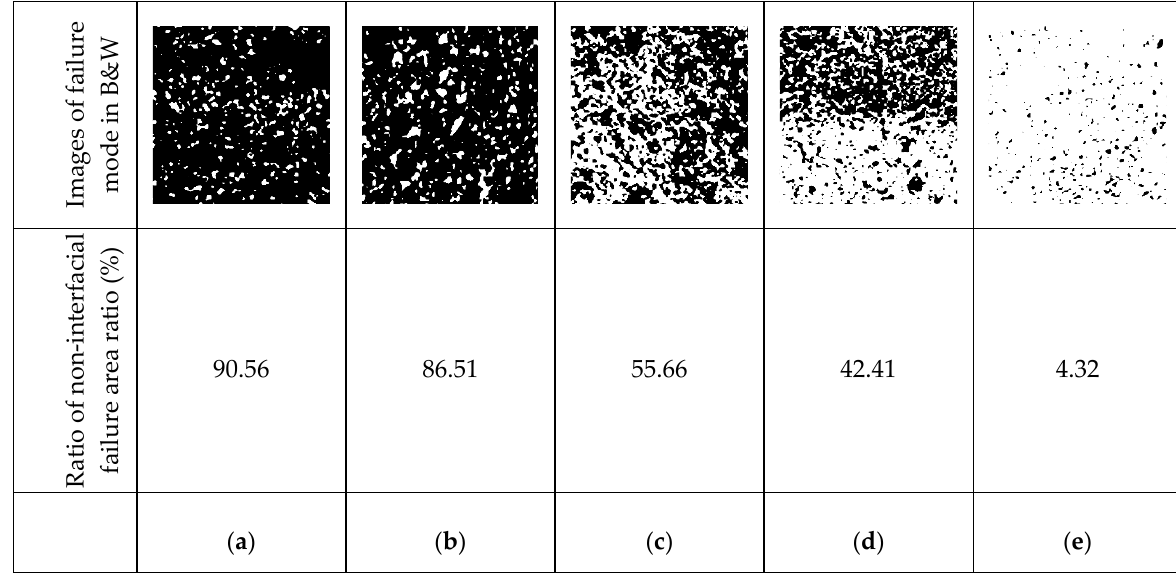
Figure 12. Relationship between the bonding strength and ∆ temperature.